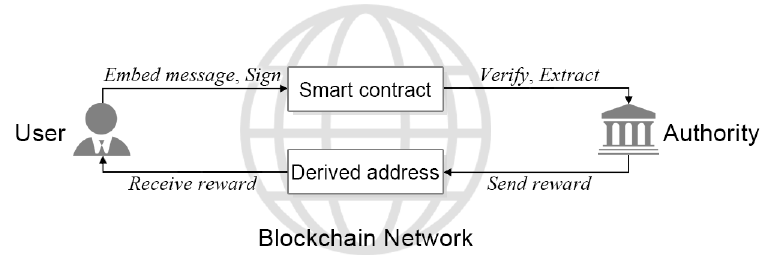
Figure 1. Structure diagram of the anonymous and covert reporting